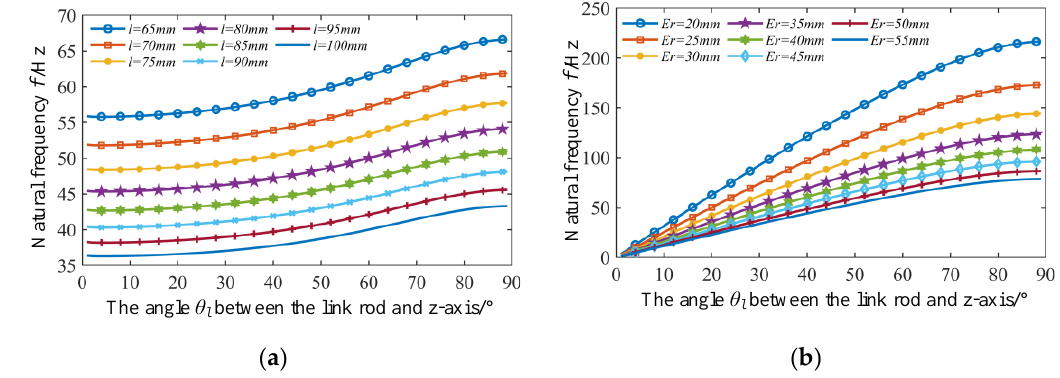
Figure 9. The change of natural frequency with variation of angle θ l . ( a ) Under the condition of different link rod length l . ( b ) Under the condition of different radius difference E r .